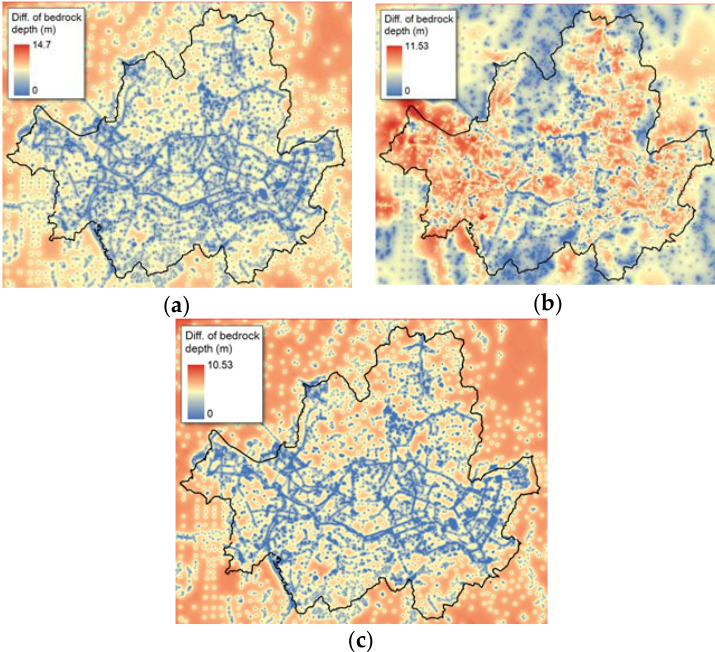
Figure 6. Spatial distribution of error between measured and predicted bedrock depth, determined using three kriging methods: ( a ) simple kriging ( b ) ordinary kriging and ( c ) empirical Bayesian kriging.